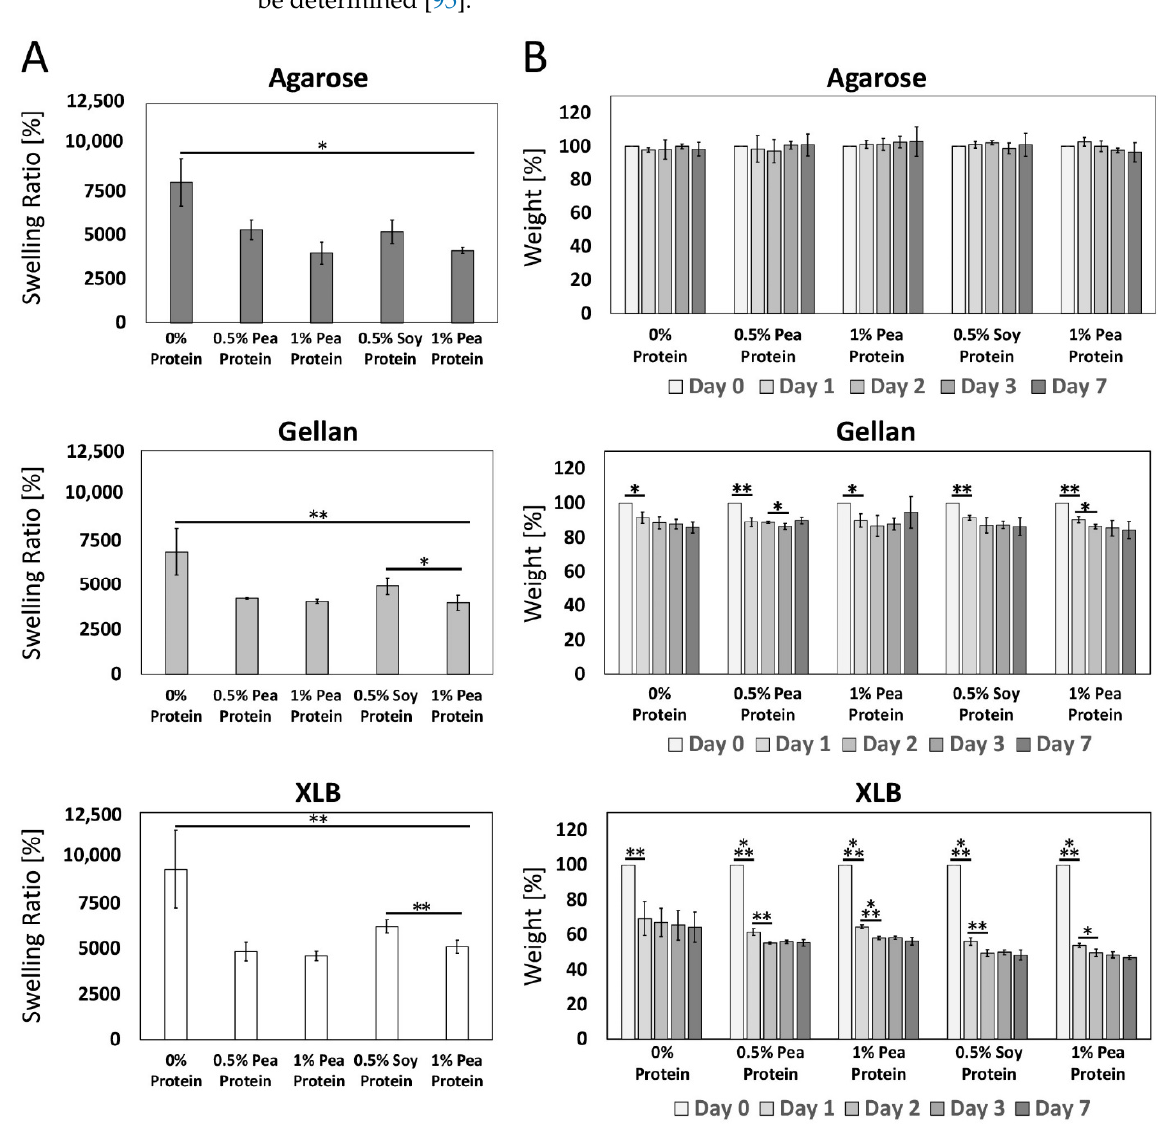
Figure 4. Swelling properties of agarose, gellan and XLB gels blended with 0%, 0.5% and 1% of pea or soy protein in gel state. ( A ) Swelling ratio of different gels ( n = 4, two-sided t student test * p < 0.05, ** p < 0.01). ( B ) Weight change of different hydrogels over seven days in medium ( n = 4, two-sided t student test * p < 0.05, ** p < 0.01, *** p < 0.001). Error bars represent standard deviations.